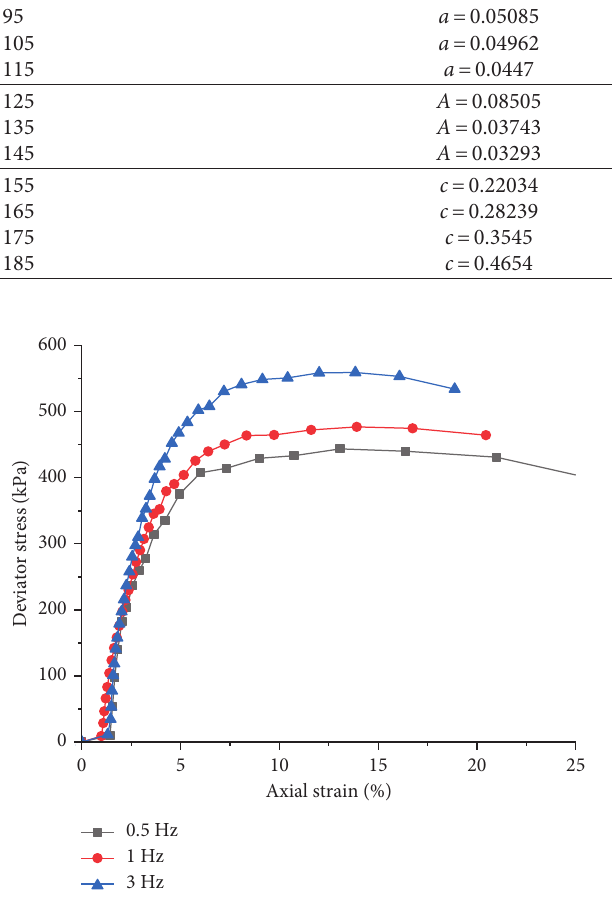
Figure 8: Stress-strain curves at different frequencies. Figure 9: Curves of dynamic elastic modulus versus dynamic stress amplitude at different